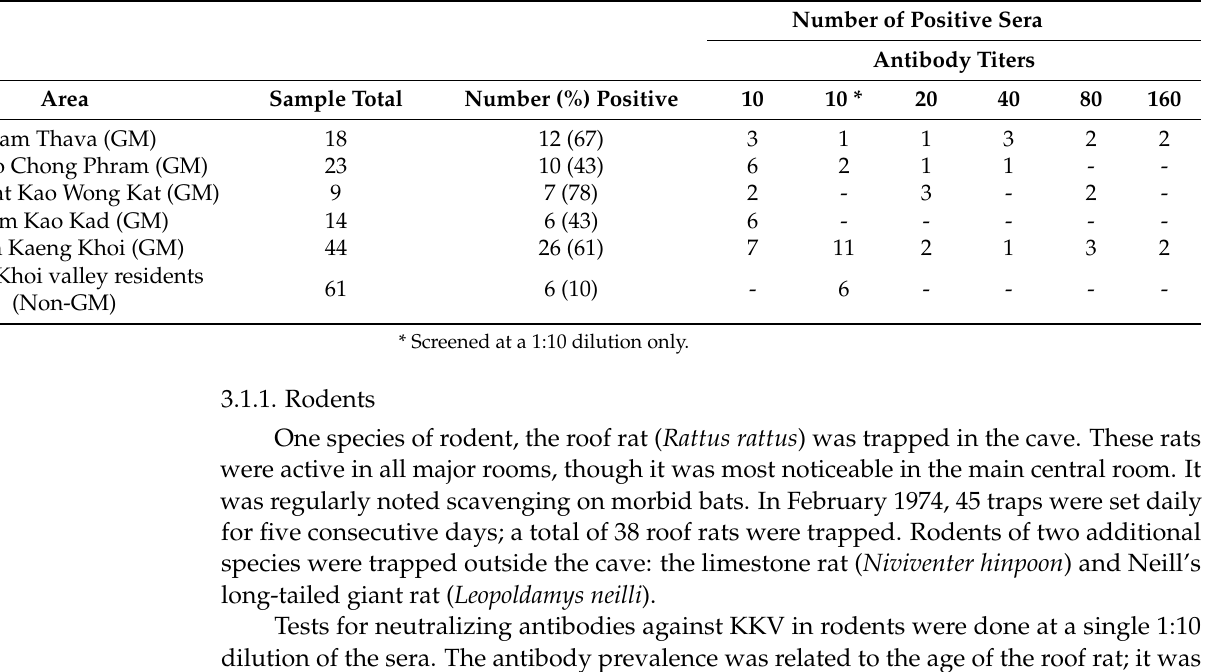
Table 1. Distribution of neutralizing antibodies against KKV in guano miners (GM) from five caves and in Kaeng Khoi valley